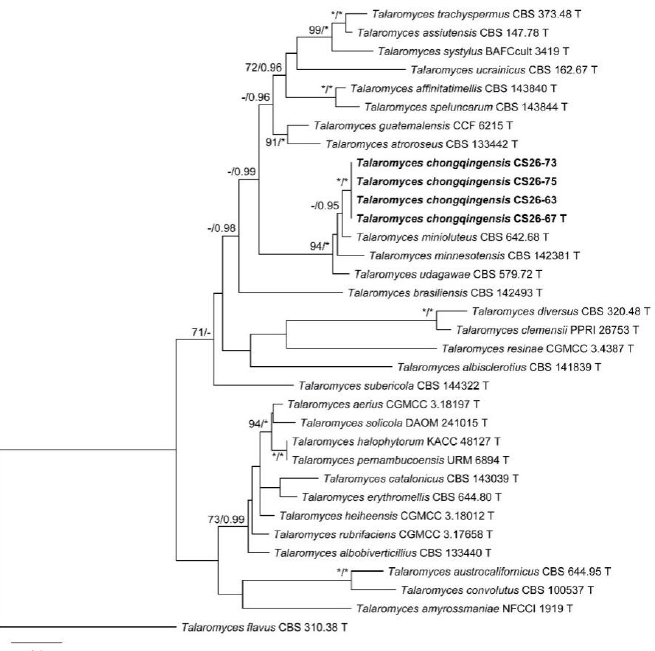
Figure 2. Maximum likelihood phylogeny of Talaromyces sect. Trachyspermi inferred from the CaM dataset. Bootstrap values ≥ 70% ( left ) or posterior probability values ≥ 0.95 ( right ) are indicated at nodes. Asterisk denotes 100% bootstrap or 1.00 posterior